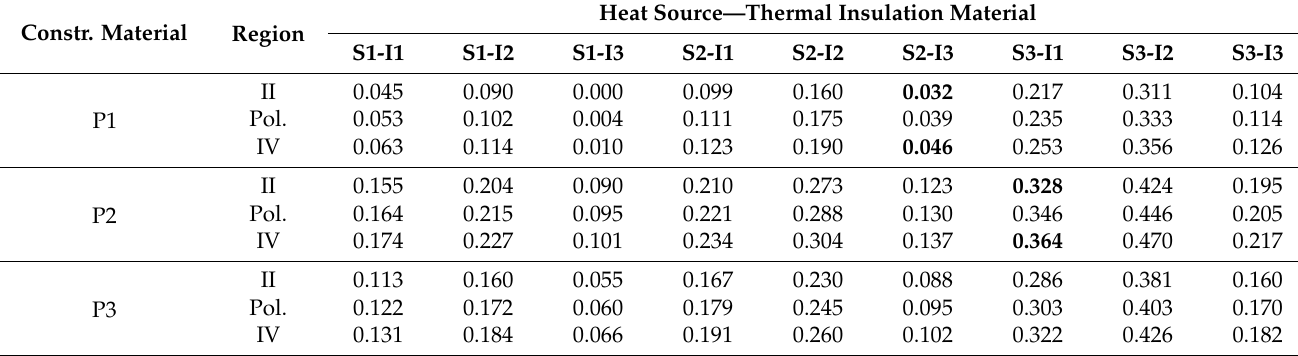
Table 6. Economically optimal thermal insulation thickness d opt